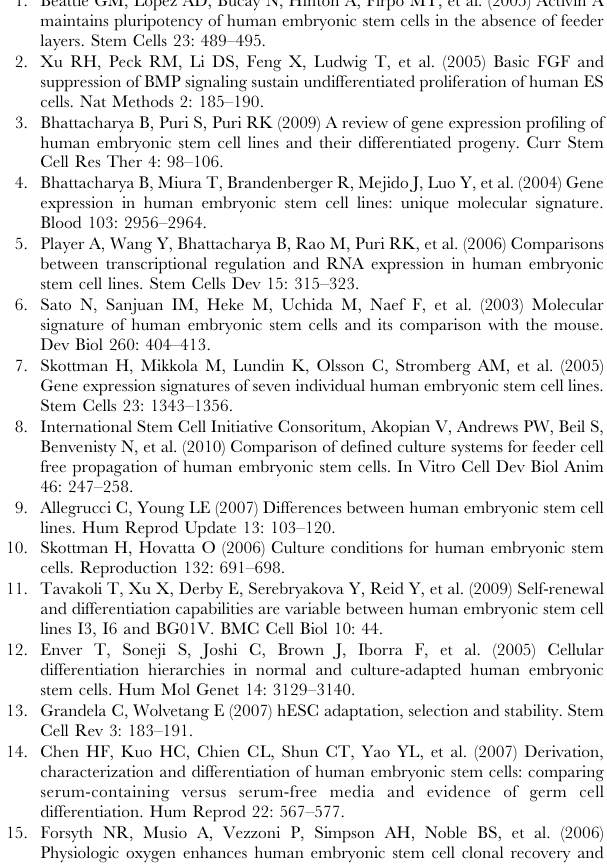
Figure S1 RT-PCR analysis of undifferentiated rhesus ESC generated from in vitro (A) or in vivo (B) derived embryos.